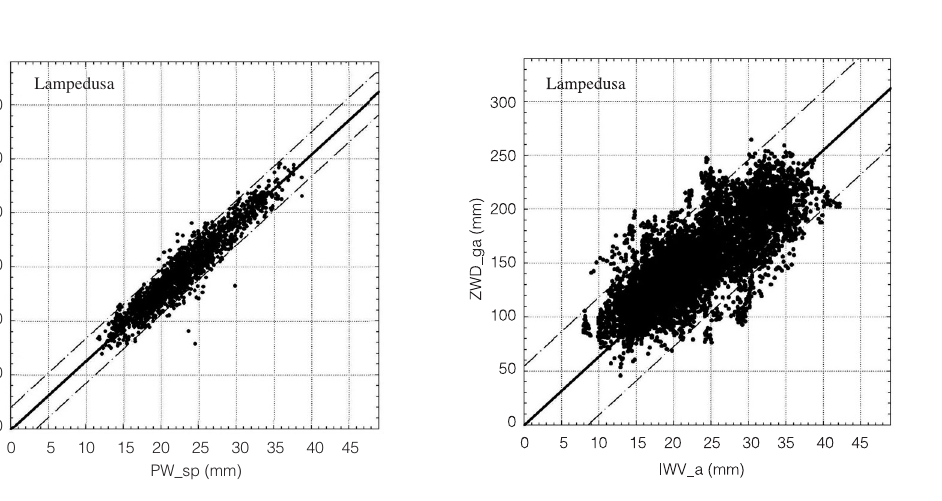
Fig. 2. (HIRLAM - GPS) ZTD differences.